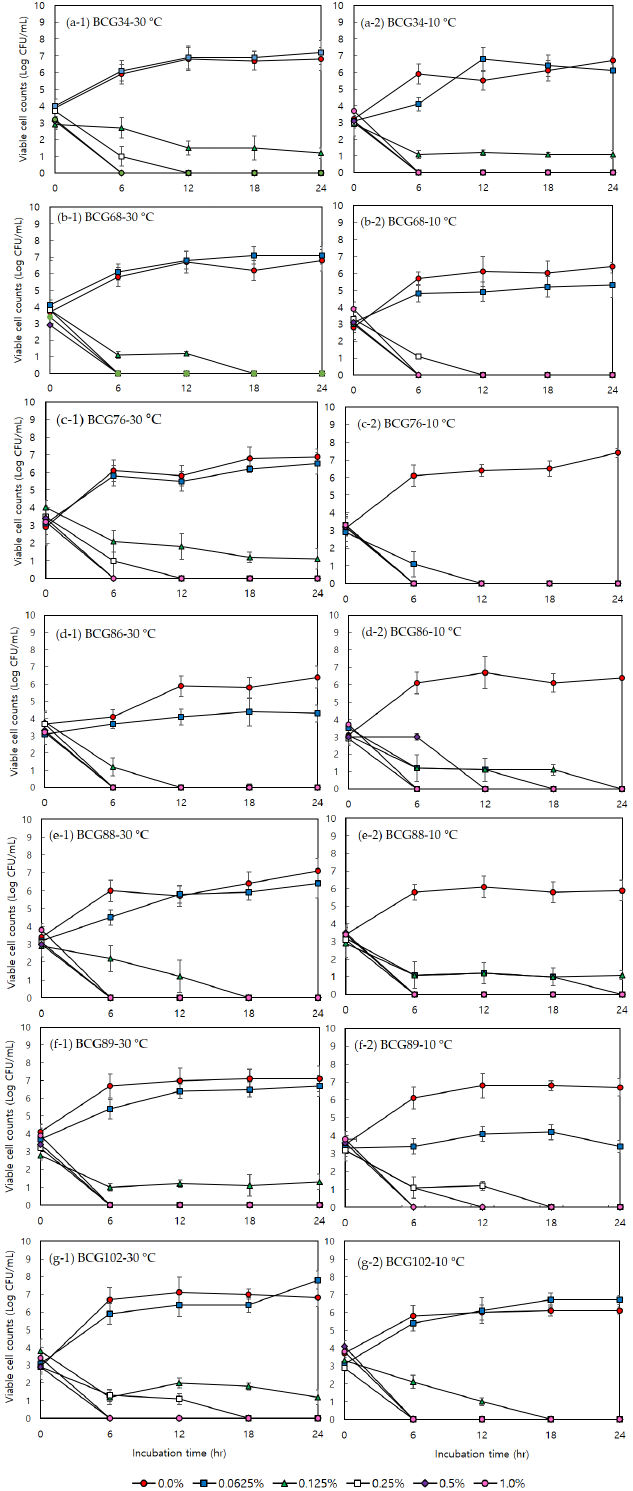
Figure 1. Growth curve experiments of seven psychrotolerant B. cereus group strains activated at 30 ◦ C ( a-1 , BCG34; b-1 , BCG68; c-1 , BCG76; d-1 , BCG86; e-1 , BCG88; f-1 , BCG89; g-1 , BCG102) and 10 ◦ C ( a-2 , BCG34; b-2 , BCG68; c-2 , BCG76; d-2 , BCG86; e-2 , BCG88; f-2 , BCG89; g-2 , BCG102) with different concentrations (0.0625, 0.125, 0.25, 0.5, and 1%) of acetic acid during 24 h. The error bars indicate standard deviation from triplicate